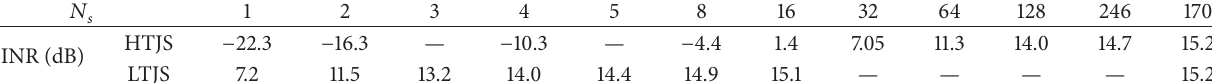
Table 4: Suboptimal WB approach in the range dimension: SINR versus 𝑁 𝑠 .